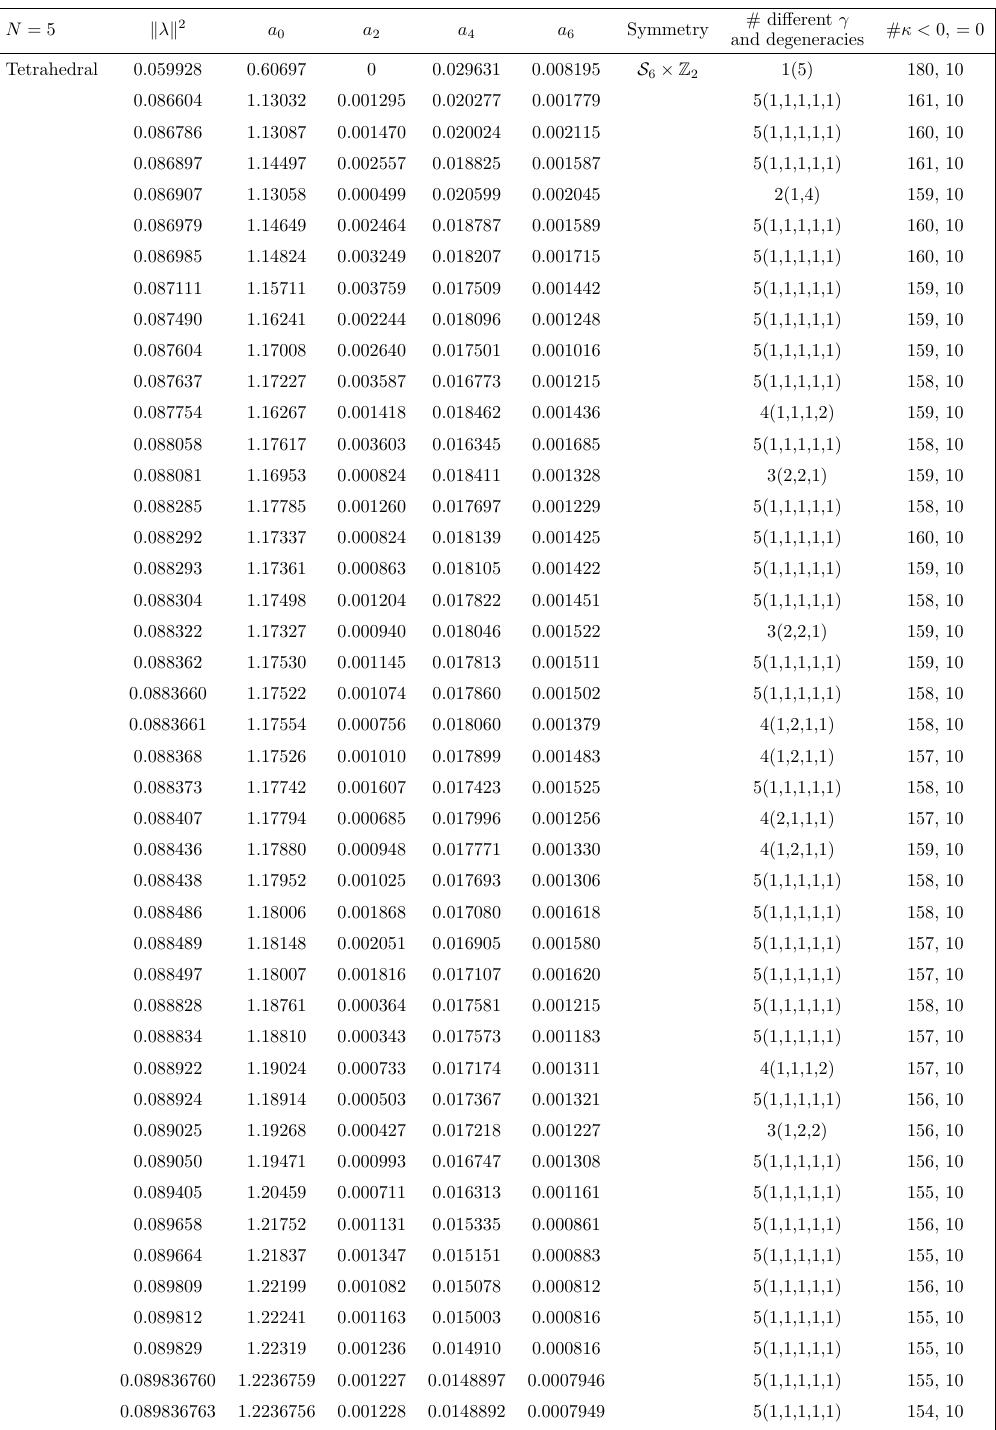
Table 4. Fully-interacting fixed points with N = 5 in d = 3 − ε